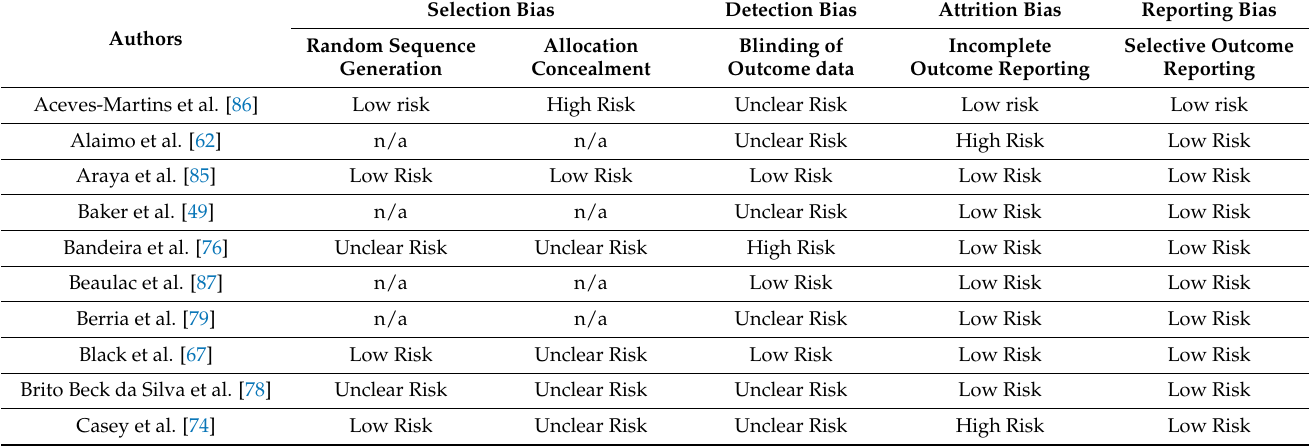
Table 2. Quality